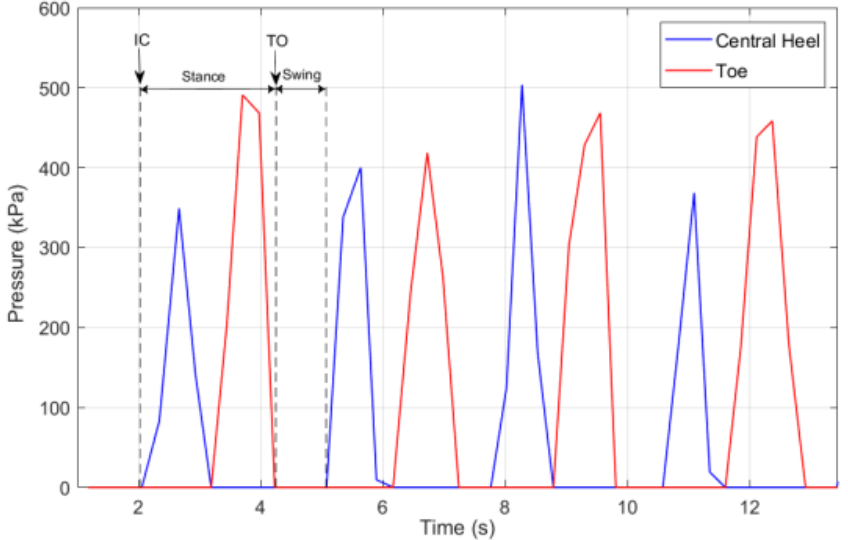
Figure 8. IC and TO were detected to separate the stance and swing phases. The percentage of gait stage is defined as the stage time over the total time of the gait cycle. The percentages of both the stance and swing stages are calculated by Equation (2).